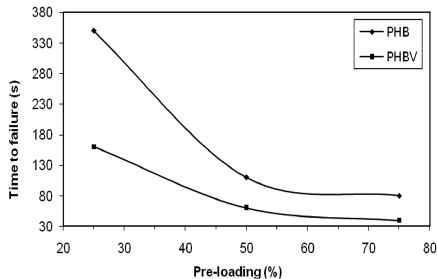
Figure 6. Stress relaxation curves for PHB-1 samples tested without (a) and with (b) NaOH.